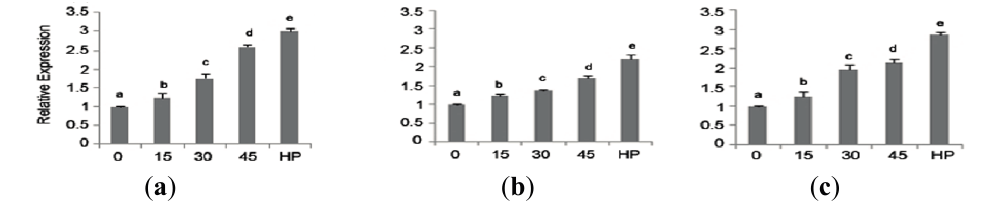
Figure 5. Expression levels of 6 different genes. ( a ) Relative expression of glutamyl-tRNA (Gln) amidotransferase subunit A; ( b ) Relative expression of photosystem II 47 kDa protein; ( c ) Relative expression of NADH: ubiquinone oxydoreductase subunit 7; ( d ) Relative expression of 26S protease regulatory subunit 6b; ( e ) Relative expression of xanthine dehydrogenase/oxidase; ( f ) Relative expression of zinc finger protein ZAT5. 0–45: MMS concentrations (mg·L − 1 ). HP: Healthy plantlets. The different letters within a gene repression level indicate significant difference, while the same letters within a gene repression level indicate no significant differences ( p <